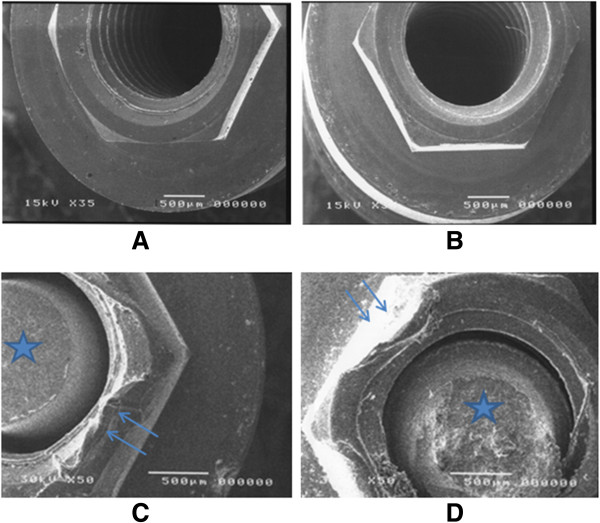
SEM of implant surfaces with exposure distances of 3.0 and 1.5 mm. (A) titanium implant in Group A1, (B) titanium implant in Group A2, (C) titanium implant with failed titanium-alloy abutment screw in Group B1, and (D) titanium implant with failed titanium-alloy abutment screw in Group B2. Stars indicate failed abutment screws, and arrows point to the damaged external hexagon of the implant.